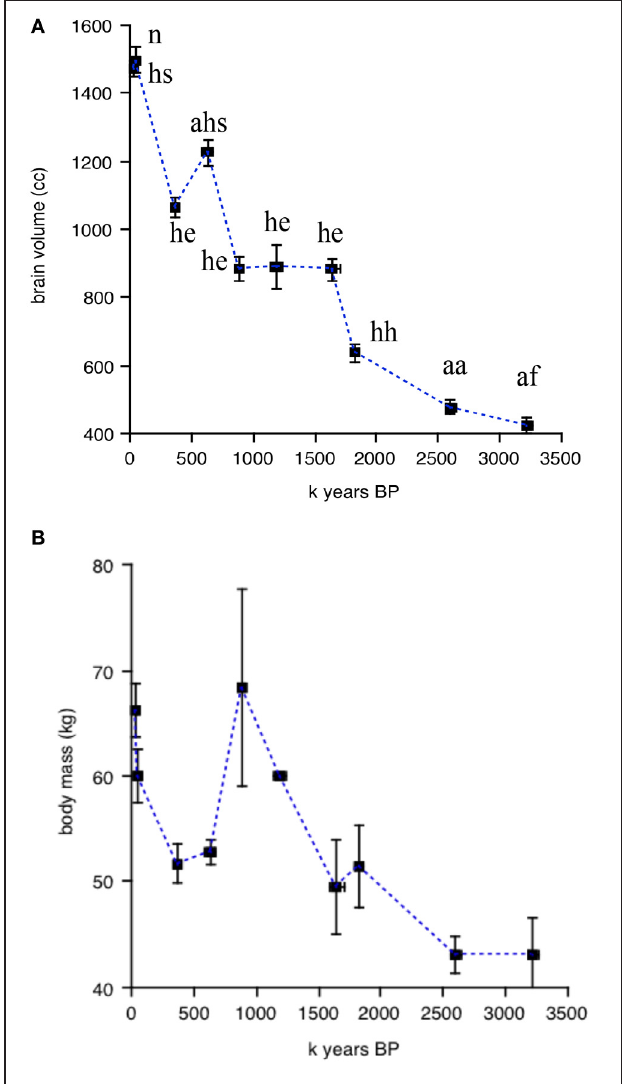
FIGURE 2 | Changes over time in absolute brain and body size averaged for periods and clades. (A) Absolute brain volume (in cc). (B) absolute body mass (in kg) over time. Data from Henneberg and colleagues; errors bars on the x and y axes represent SEM’s. Abbreviations above each data point in (A) correspond to the ten clades in Table 1 ; data points in (B) as in (A)